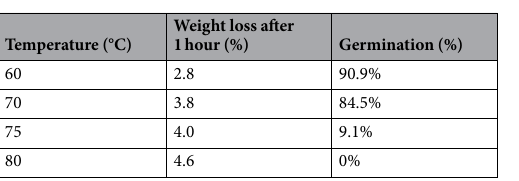
Table 1. Effect of temperature on weight loss and germination of nasturtium